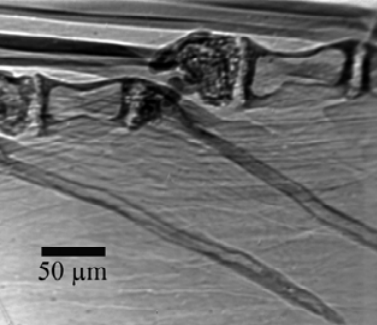
Figure 17. Refractive index microradiograph of a detail of a live 5-mm aquarium fish (data from Ref. 25).